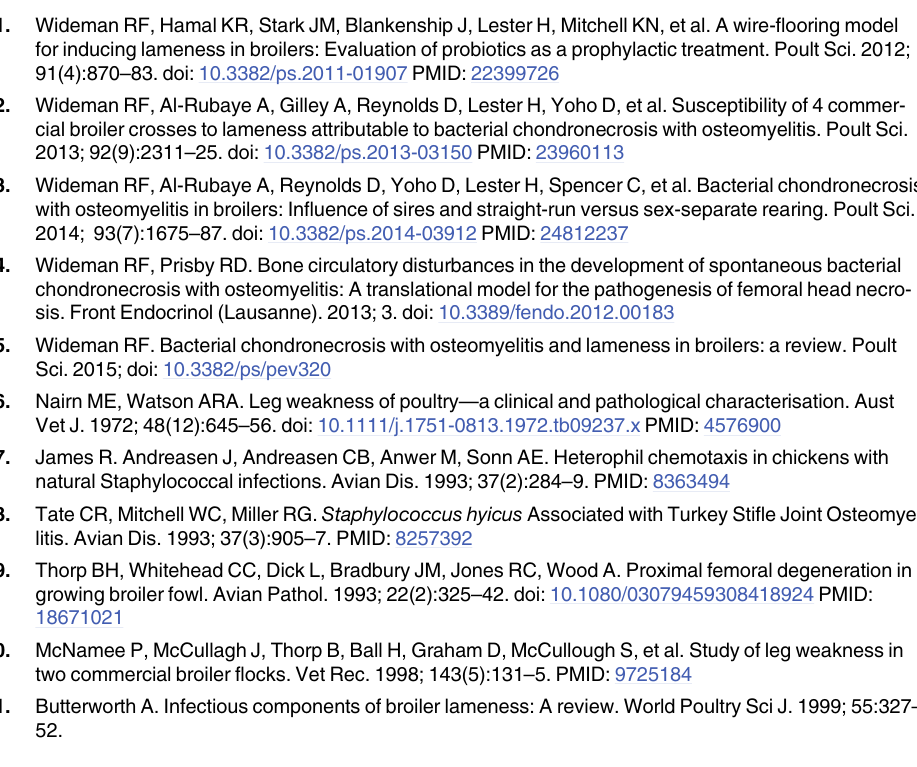
S3 Table. Significant BLASTp hits of translation products from the S . agnetis 908 29 kbp plasmid. Details are as for S1